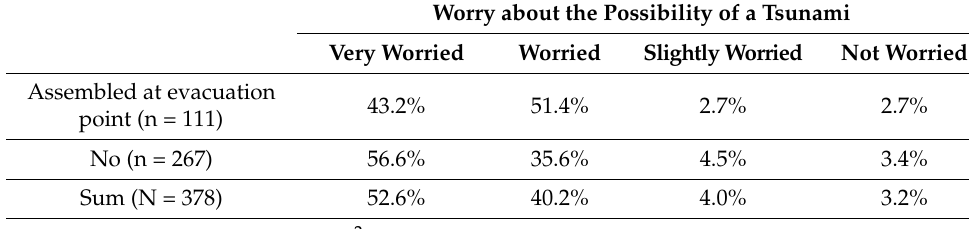
Table 3. Worry about the possibility of a tsunami.